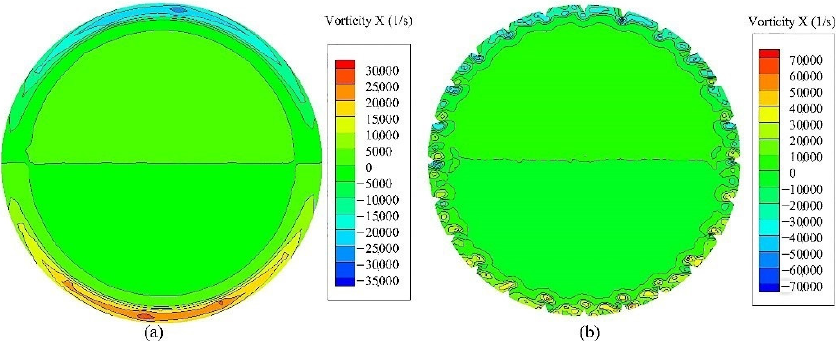
Figure 17. X-vorticity nephogram of vertical flow section in ( a ) prototype and ( b ) bionic tailpipe. Table 4. The surface friction coefficient of the tailpipe wall at different inlet velocities. Velocities